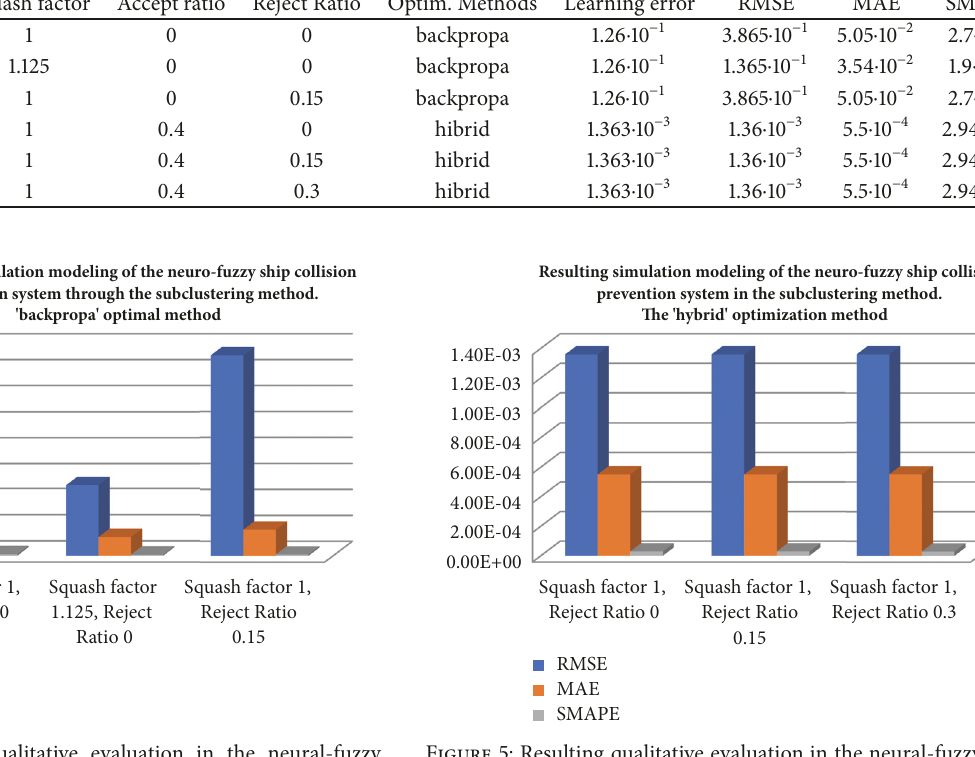
Table 2: Resulting simulation modelling of the neural-fuzzy ship collision prevention system through subclustering generation method. Range of influence Squash factor